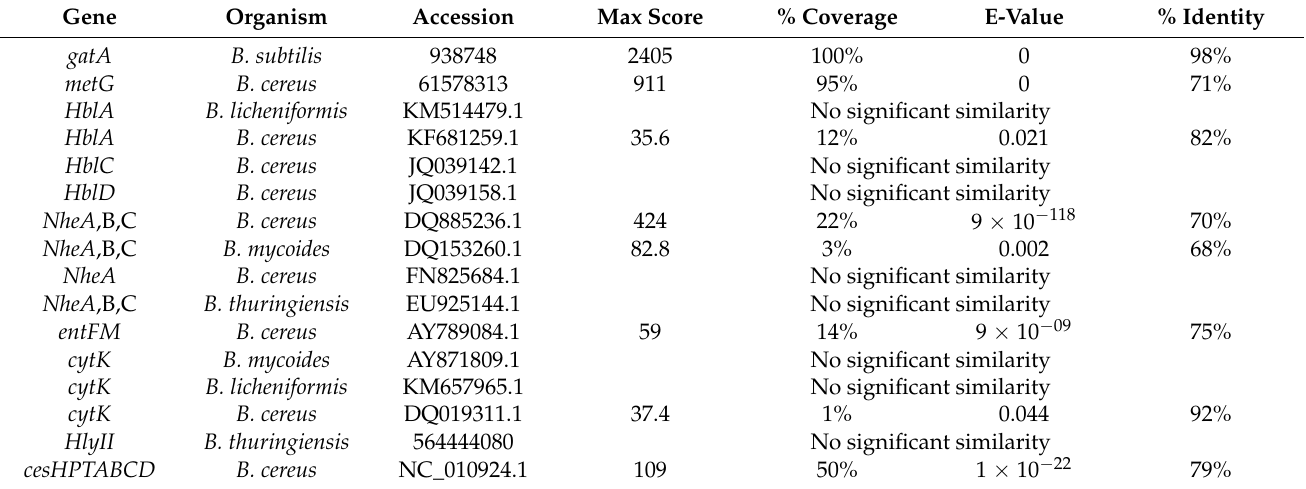
Table 1. Summary of BLASTn screening results for known Bacillus toxin genes in the BS50